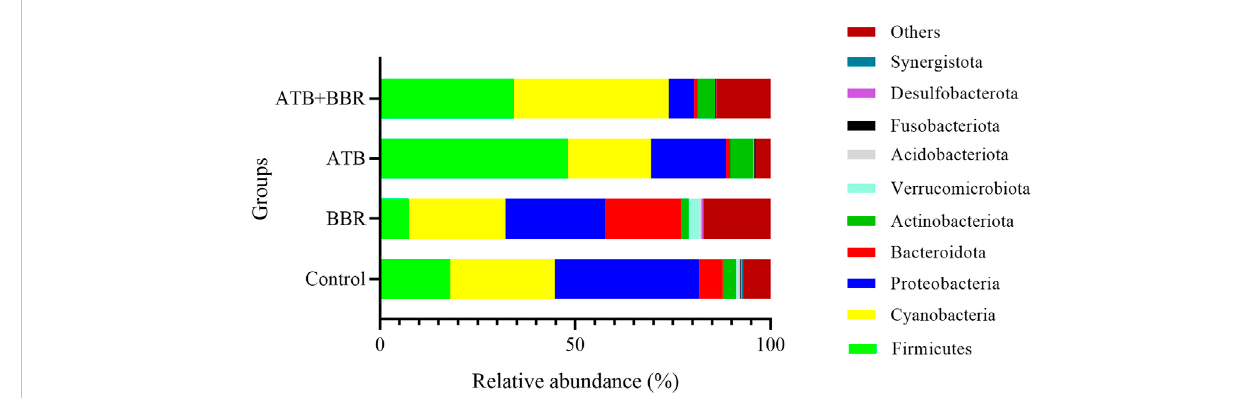
FIGURE 1 Composition of gut microbiota at the phylum level in largemouth bass. BBR, berberine; ATB, antibiotics.